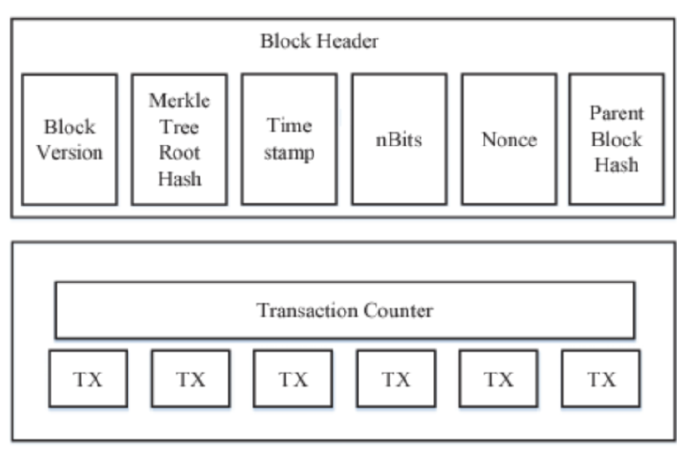
Figure 2: Block Structure; Source: Zheng et al